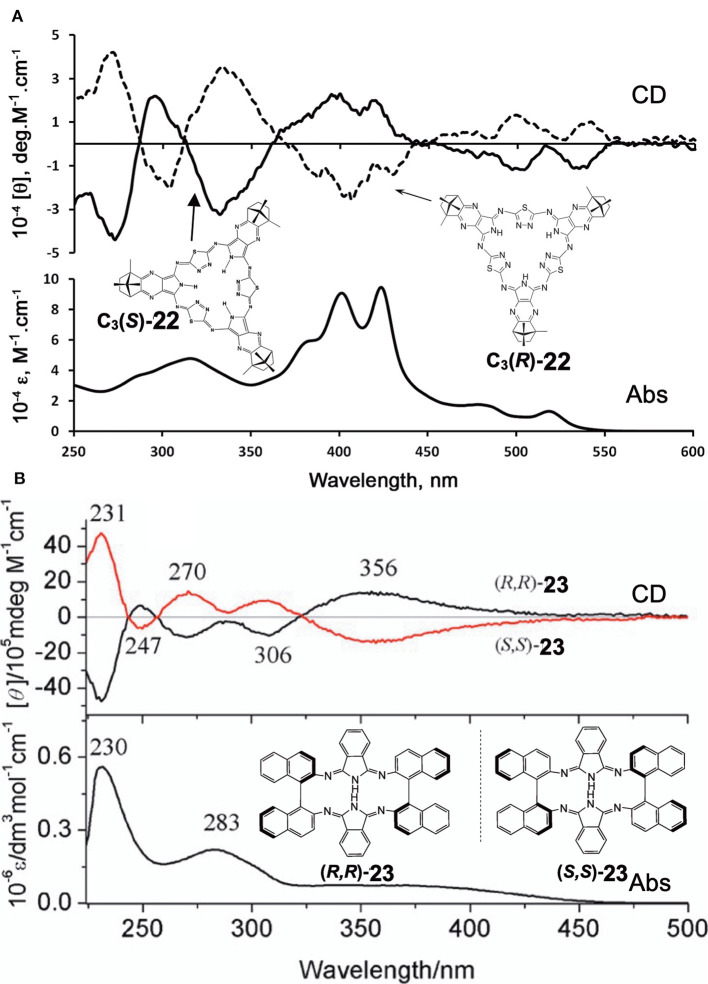
Electronic absorption and MCD spectra of (A)
C3(S)- and C3(R)-22 and (B) (R,R)-23 and (S,S)-23. Adapted from Filatov et al. (2014) and Wu et al. (2016).